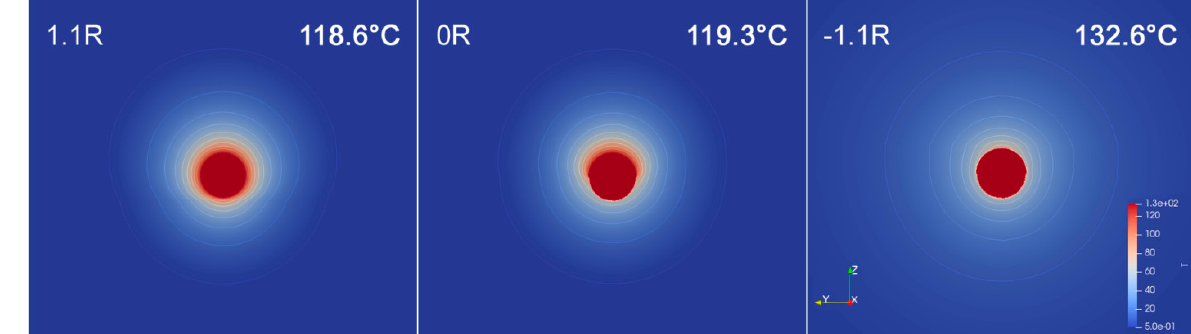
Figure 15. Temperature cross section of AgNPs at the end of laser pulse with respect to their immersion depth in PET (1.1r, 0r, − 1.1r, according to Figure 14). Insets in right upper corner refer to maximal temperature in the nanoparticle core.